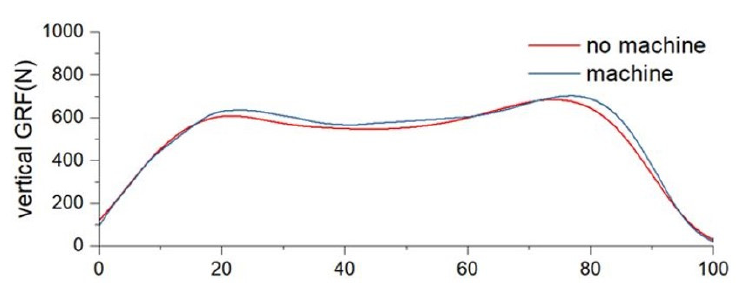
Figure 23. Ground reaction forces at walking.